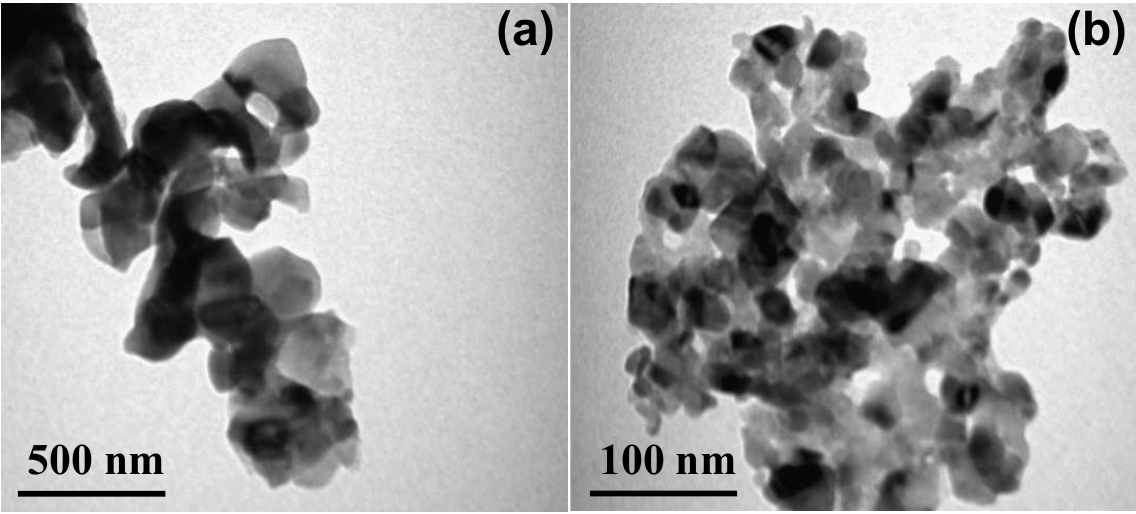
Figure 3. ( a,b ) TEM images of the Ag-C-2 nanohybrid. The successful formation of Ag-CuO bimetallic nanohybrids was confirmed from XRD analysis as described elsewhere [36]. The XRD spectrum indicates a good crystalline structure of the Ag-CuO nanohybrids (Ag-C-2). The XRD patterns of the as-synthesized bimetallic Ag-CuO nanohybrids consist of sharp peaks, which indicated the crystallinity of the produced particles. The XRD patterns of the Ag-CuO in Figure 4 were consistent with CuO/Cu 2 O and Ag/Ag 2 O crystals. The appearance of a distinct sharp peak at 32.35 ◦ , 38.45 ◦ and 48.42 ◦ can be assigned to the (002), (111), and (202) crystal lattice of the